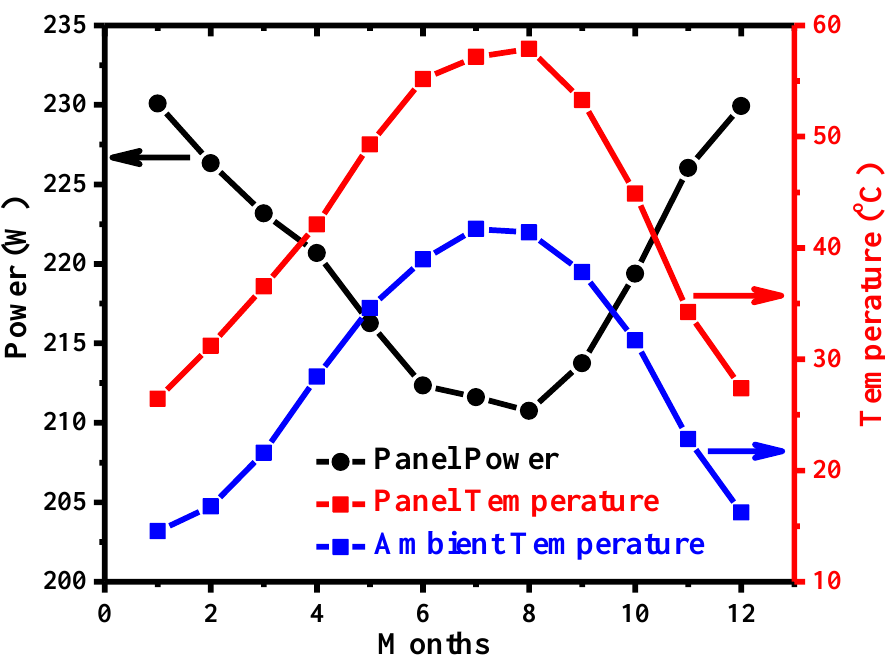
Figure 8. Temperature effect on the PV rated